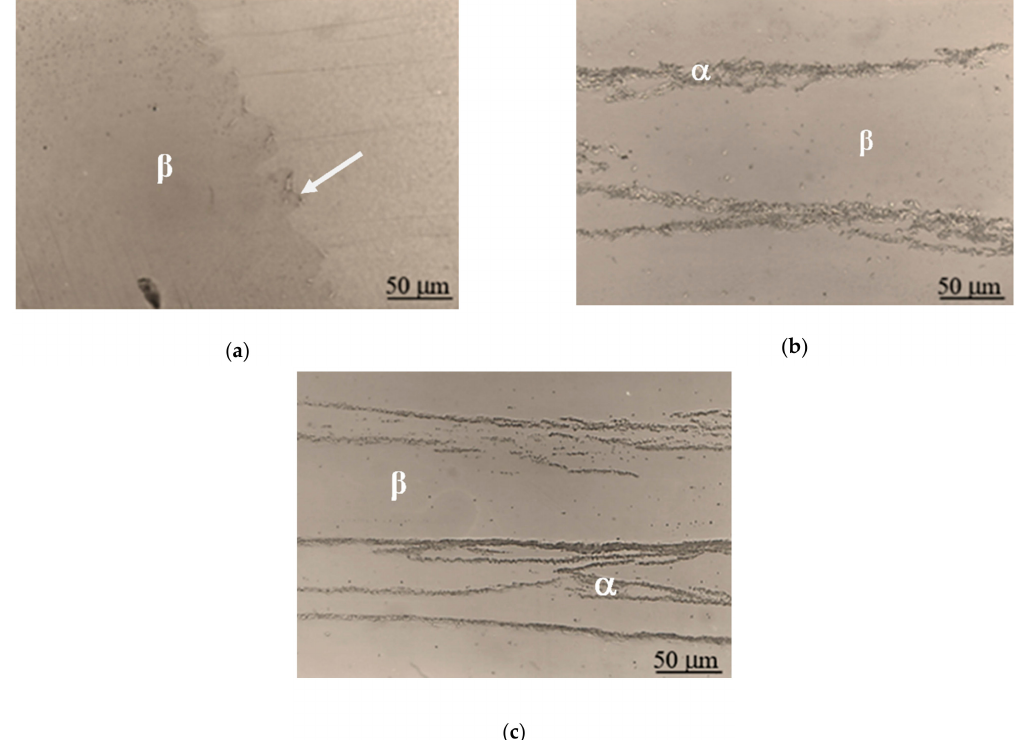
Figure 7. Microstructure of ausforming-treated alloy with true strain: ( a ) 20%; ( b ) 98%; ( c )